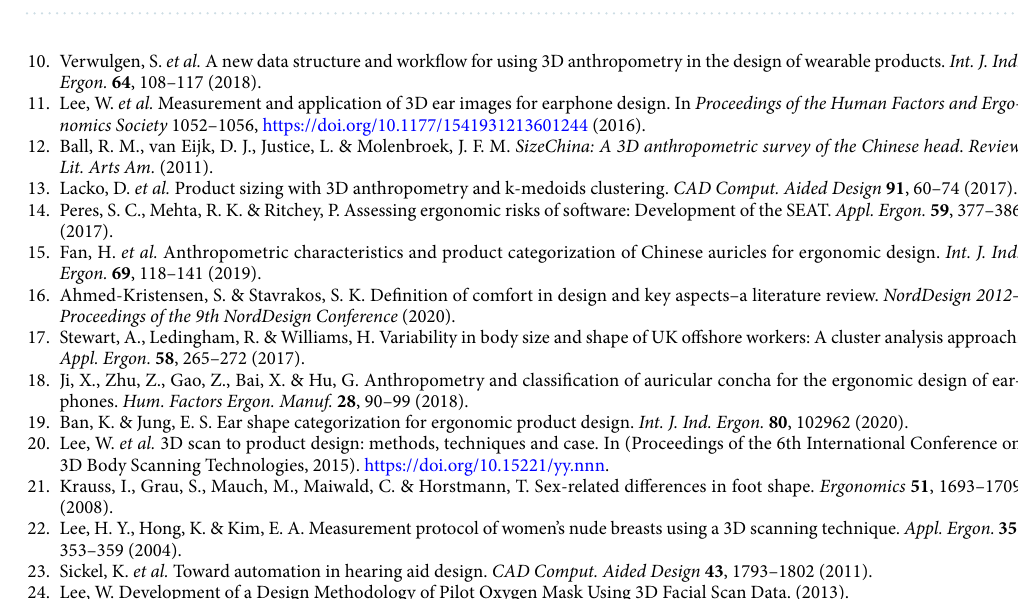
Figure 12. The visual effect between antitragus and earphone by deviation analysis tool of CATIA (right) and deviation analysis algorithm